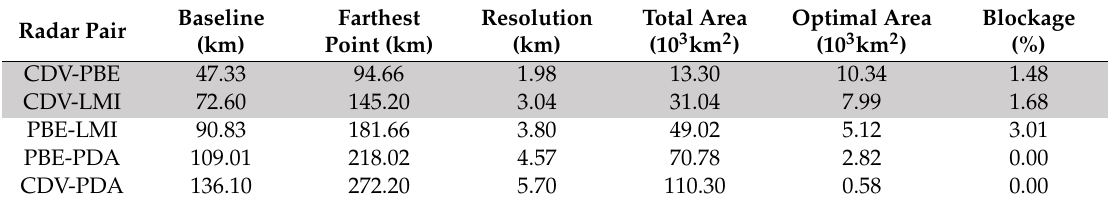
Table 2. Dual-Dopplerri network coverage characteristics for the XRAD, considering a crossing-beam angle of 30 ◦ . The two pairs used are shaded in grey.